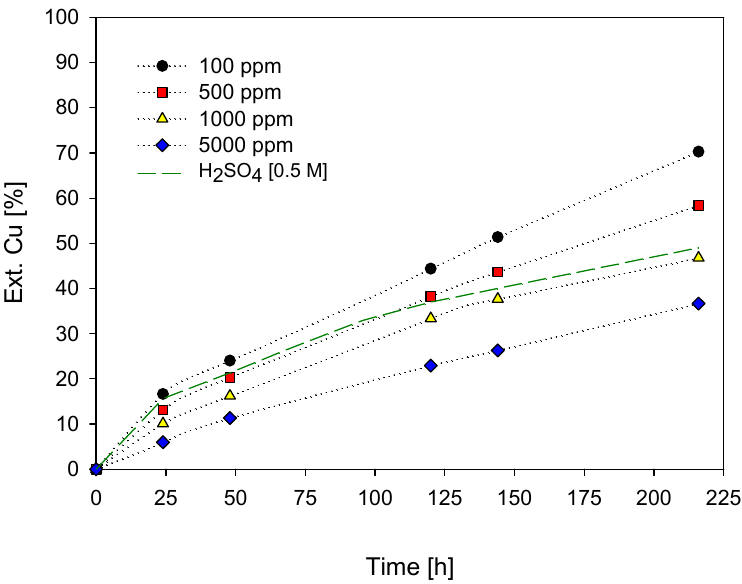
Figure 5. % Cu Ext. vs leaching time. [KI] = ( ) = 100 ppm; ( ■ ) = 500 ppm; ( ▲ ) = 1000 ppm; ( ) =